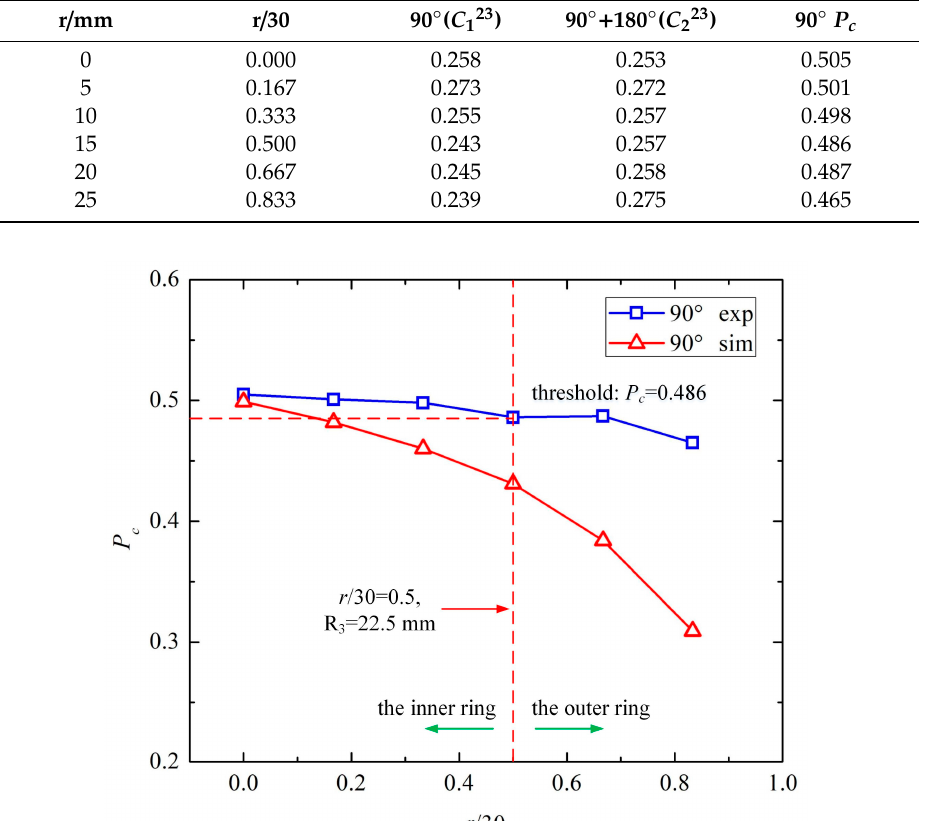
Table 5. The measured capacitance (pF) and relative proportion of capacitance between E2 and E3 ( P c ).